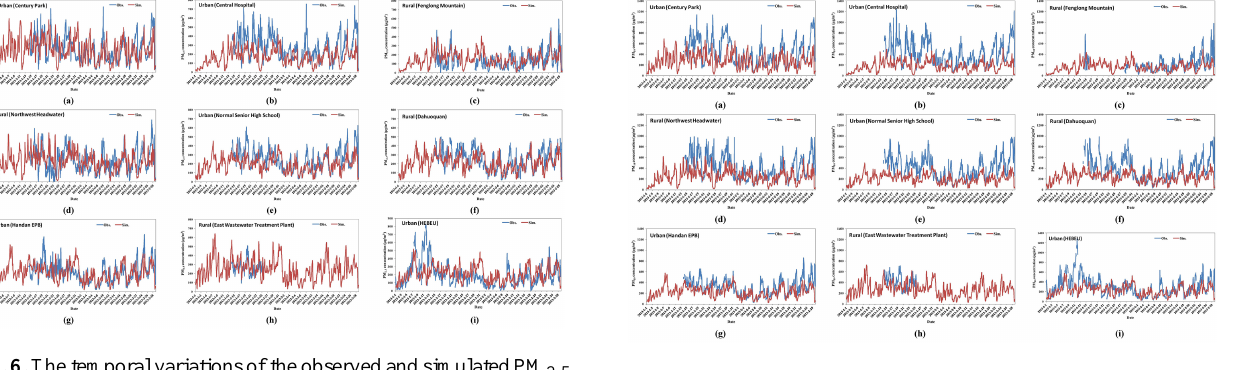
Fig. 7. The temporal variations of the observed and simulated PM 10 concentrations at the monitoring sites in Shijiazhuang, Xingtai, and Handan in January and February, 2013. (a–d) are the sites in Shi- jiazhuang, (e, f) are the sites in Xingtai, and (g–i) are the sites in